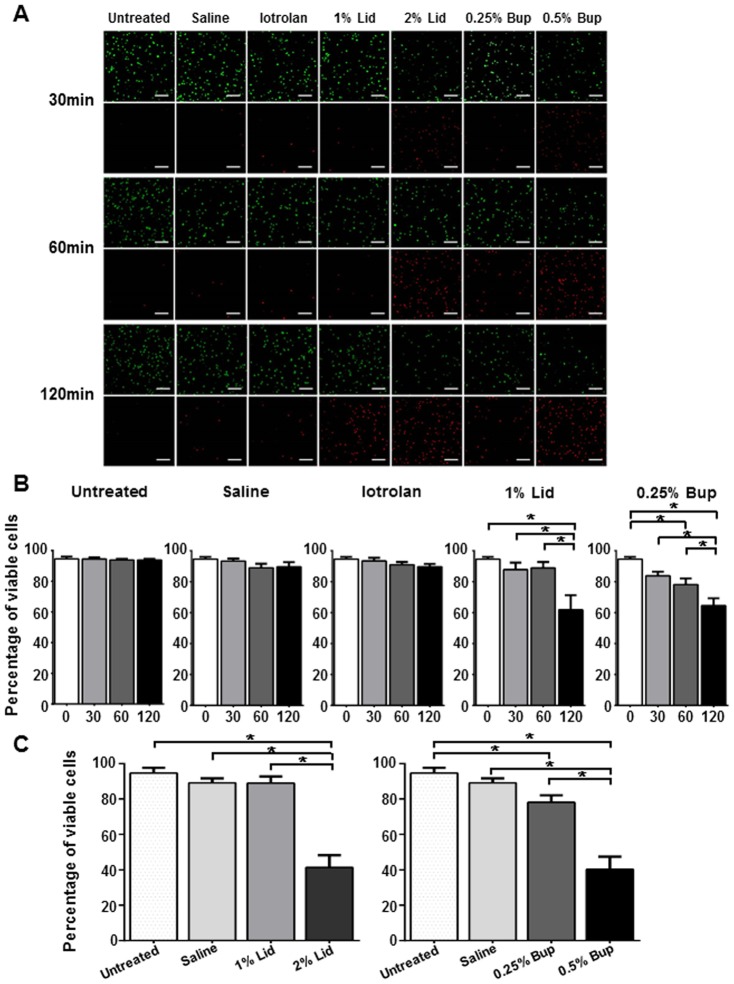
Impact of radiocontrast agents and local anesthetic agents on the viability of human nucleus pulposus (NP) cells.NP cell–alginate 3D composites were exposed to saline, radiocontrast agent (iotrolan) or local anesthetic agents (lidocaine and bupivacaine) for 30, 60, or 120 min. After an additional 24 h, they were stained with calcein AM (live cells; green) and propidium iodide (PI; dead cells; red). (A) Confocal laser scanning micrographs of the NP cell–alginate 3D composites after the exposures. Scale bar: 100 μm. (B) Time-dependent effects on cell viability. (C) Dose-dependent effects on viability after 60 min. All data are from five independent experiments (mean ± SE; *, p<0.05). Bup, bupivacaine; Lid, lidocaine.